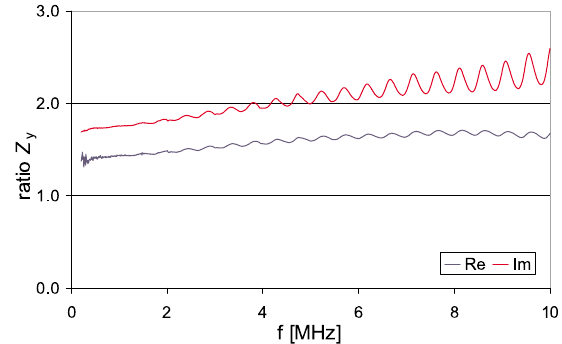
FIG. 26. (Color) Ratio of system impedance with K11 and prototype magnet.